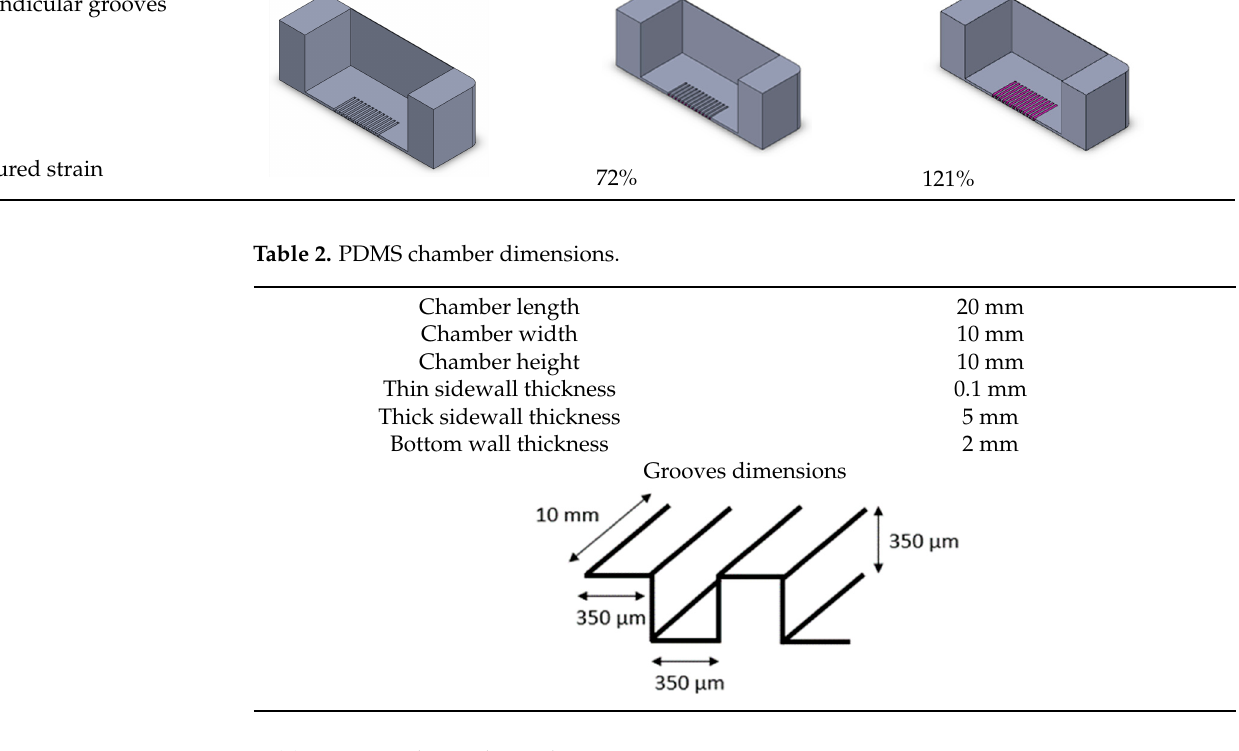
Table 3. Materials’ mechanical